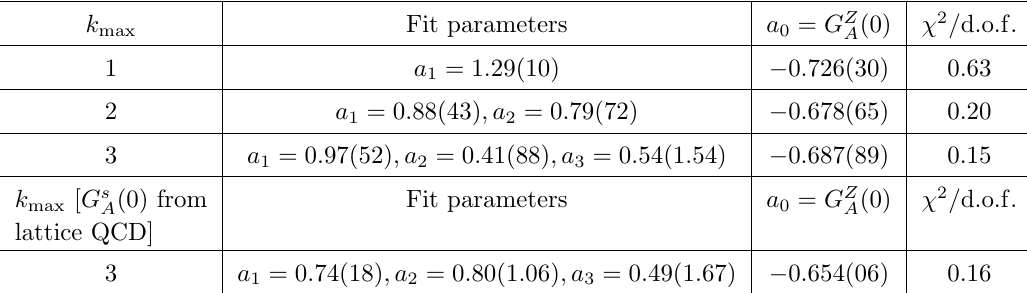
( Q 2 ) with 2, 3, and 4 terms. The A